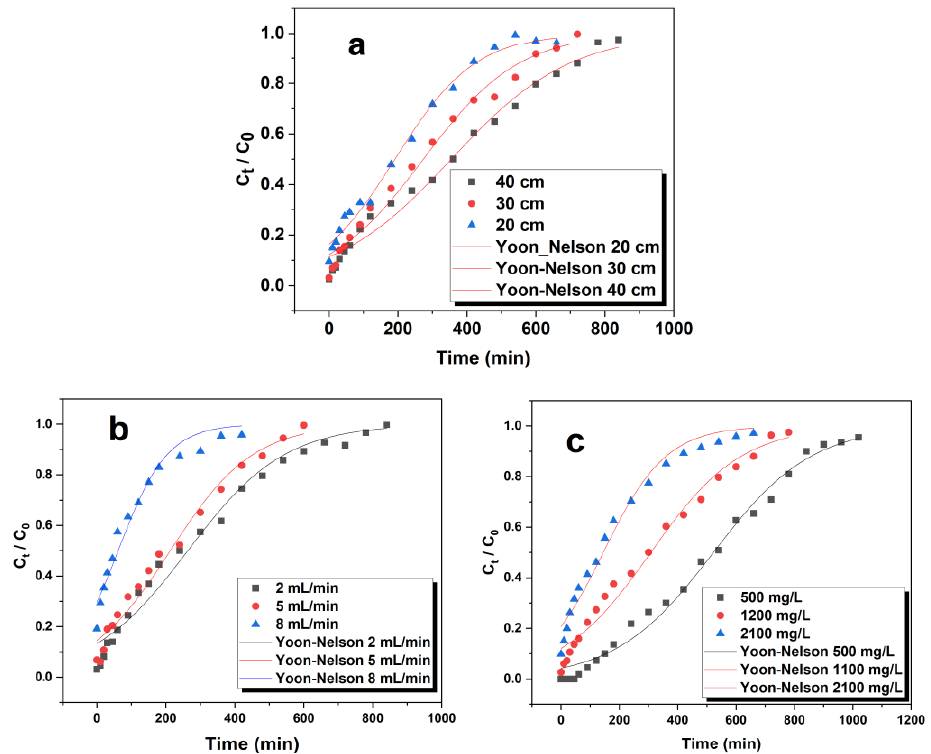
Figure 11. Predicted breakthrough curves by the Yoon–Nelson Model. ( a ) variable bed height conditions, ( b ) variable inflow rate, and ( c ) variable initial sulfate concentration.